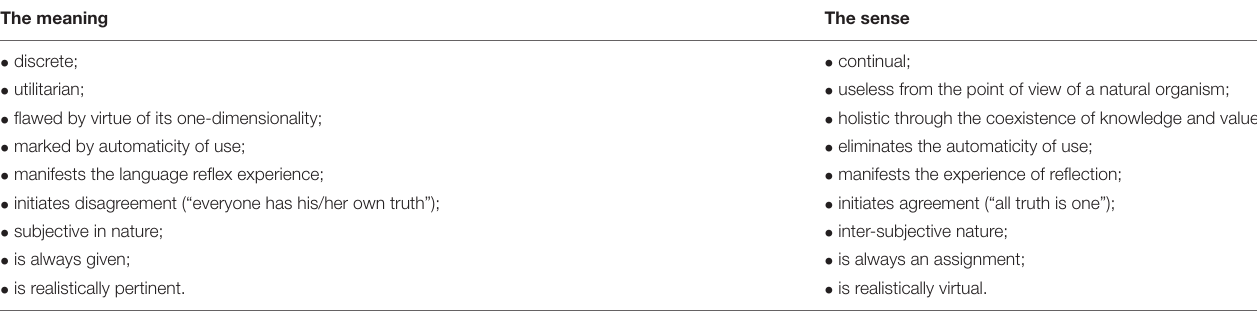
TABLE 1 | Comparative characteristics of meaning and sense. The meaning The sense